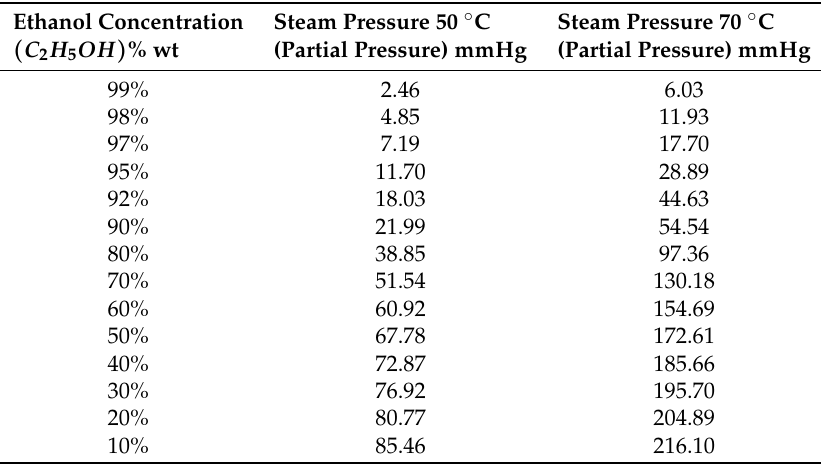
Table A4. Measurement of different concentrations ( C 2 H 5 OH ).